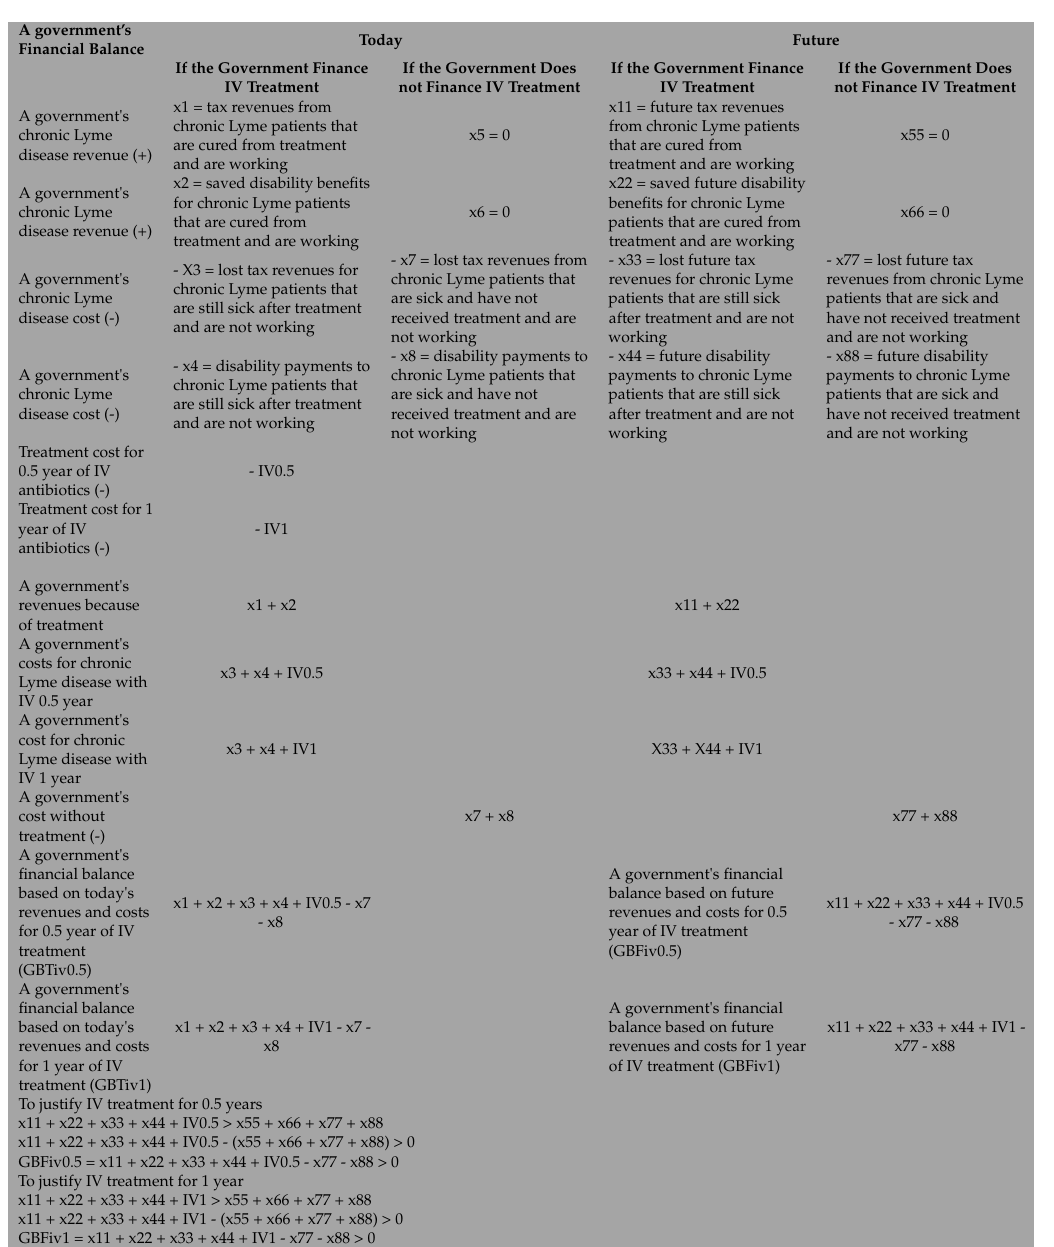
Table 16. A government’s financial chronic Lyme disease balance